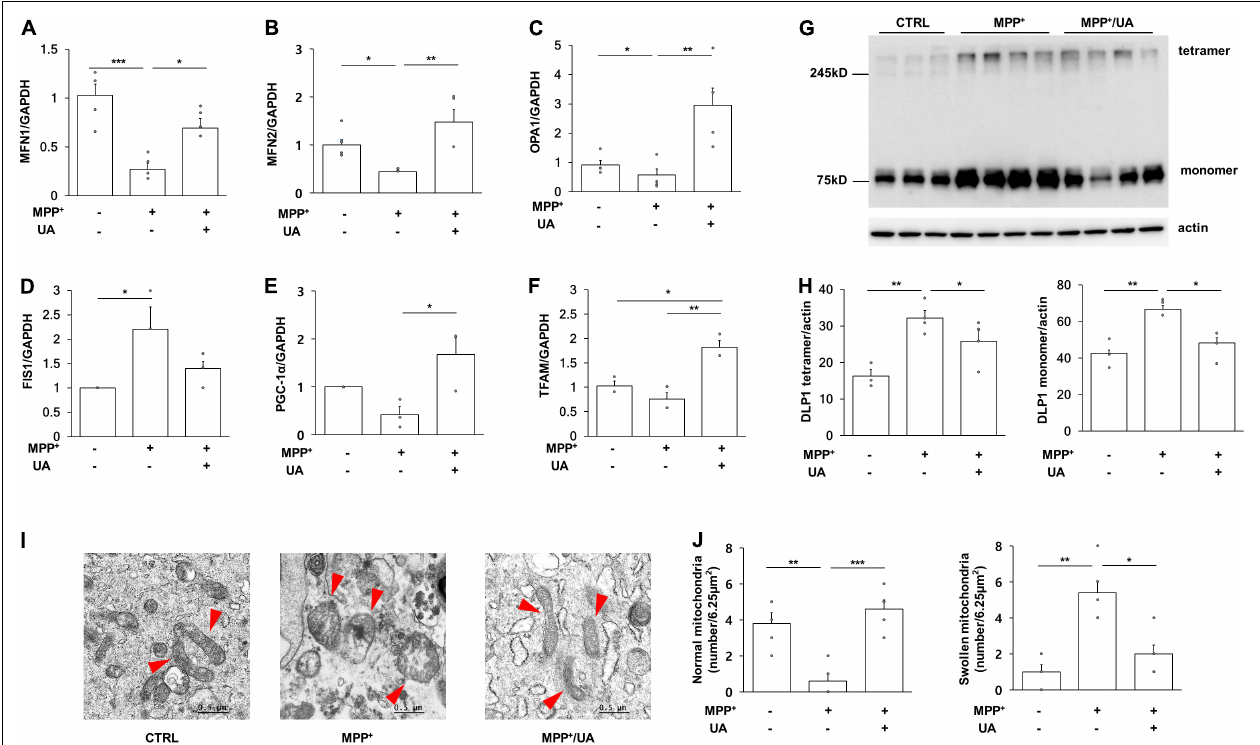
FIGURE 3 | UA treatment rescued the mitochondrial phenotype via modulating mitochondrial dynamics in NPCs. (A) Quantitative RT-PCR for mitochondrial fusion marker, MFN1. (B) Quantitative RT-PCR for mitochondrial fusion marker, MFN2. (C) Quantitative RT-PCR for mitochondrial fission marker, OPA1. (D) Quantitative RT-PCR for mitochondrial fission marker, FIS1. (E) Quantitative RT-PCR for mitochondria master regulator, PGC-1 α . (F) Quantitative RT-PCR for mitochondrial transcription factor TFAM. MPP + treatment led to a significant decrease in the expression level of MFN1, MFN2, PGC-1 α , and TFAM and UA treatment has restored it. On the contrary, the expression level of FIS1 and OPA1 was increased when exposed to MPP + -, and UA treatment restored it ( n = 5 per group). (G,H) Western blot for mitochondrial fission regulator Dlp1 tetramer and monomer form. Both tetramer and monomer form were increased with MPP + treatment, which was rescued by UA ( n = 3 for CTRL group, n = 4 for MPP + and MPP + /UA group). (I) TEM analysis revealed that MPP + treatment induced severe abnormal morphology of mitochondria with a swollen body and fragmented phenotype. However, UA treatment returned mitochondria morphology to a similar state as control NPCs. The arrows indicate mitochondria. (J) MPP + treated NPCs showed reduced normal mitochondria and increased swollen mitochondria, however, UA treatment rescued it. Differences among the conditions were evaluated by ANOVA with a Bonferroni correction for multiple comparison. The data are presented as mean ± SE. * p < 0.05, ** p < 0.01, and *** p <